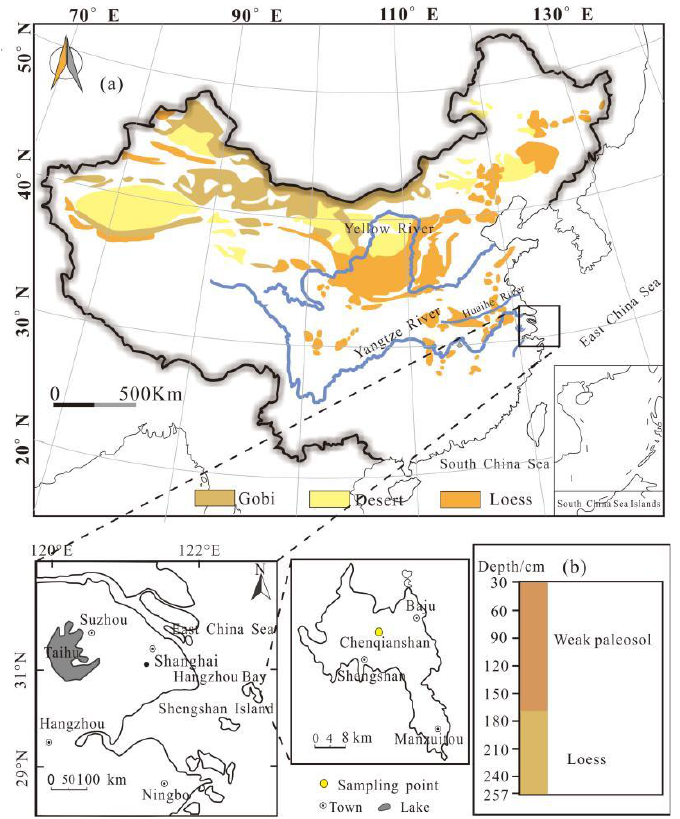
Figure 1. ( a ) Location of the Chenqianshan loess section at Shengshan Island in the East China Sea (modified from Cheng [22]) and ( b ) the alternation of loess and weak paleosol units in the Chenqianshan section.